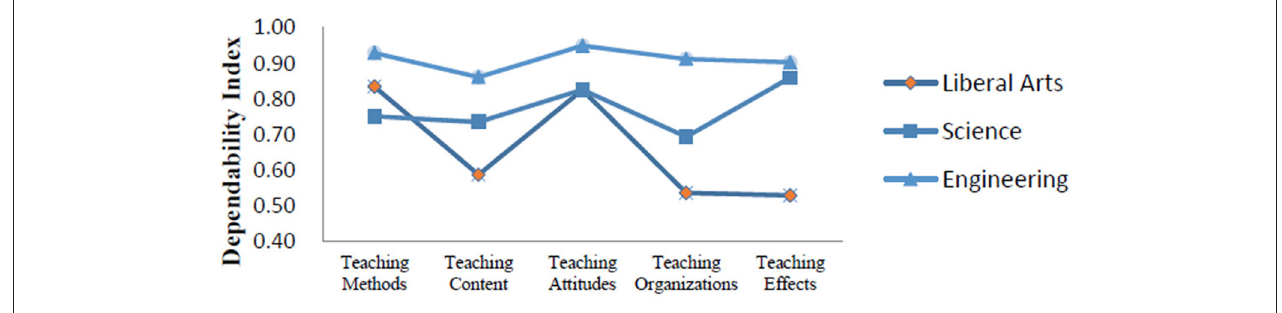
FIGURE 3 | Dependability indexes for three major types.